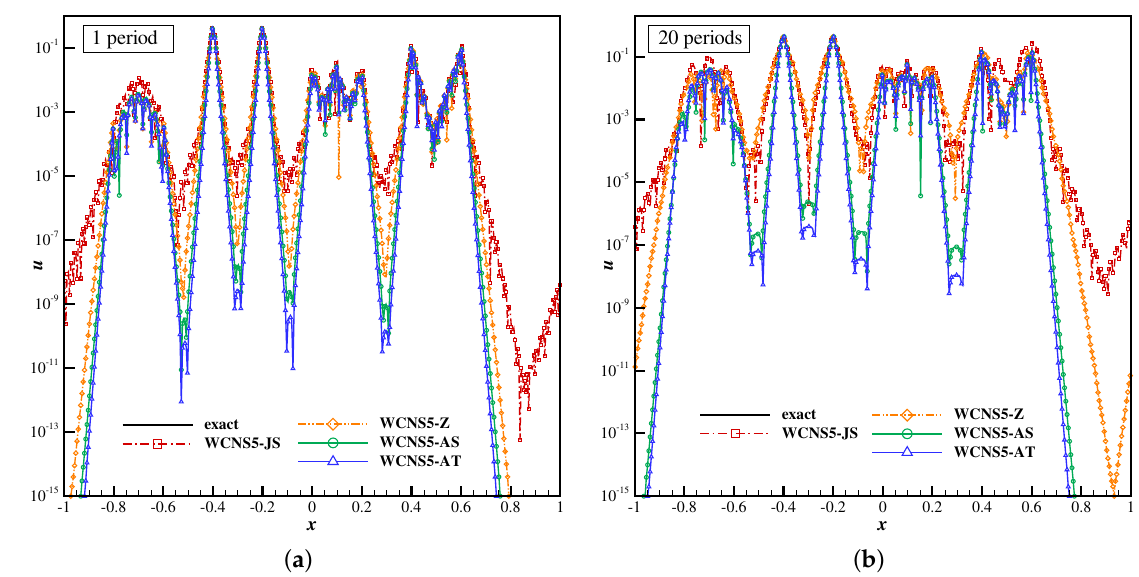
Figure 11. Error distribution of composite wave: ( a ) 1 period; ( b ) 20